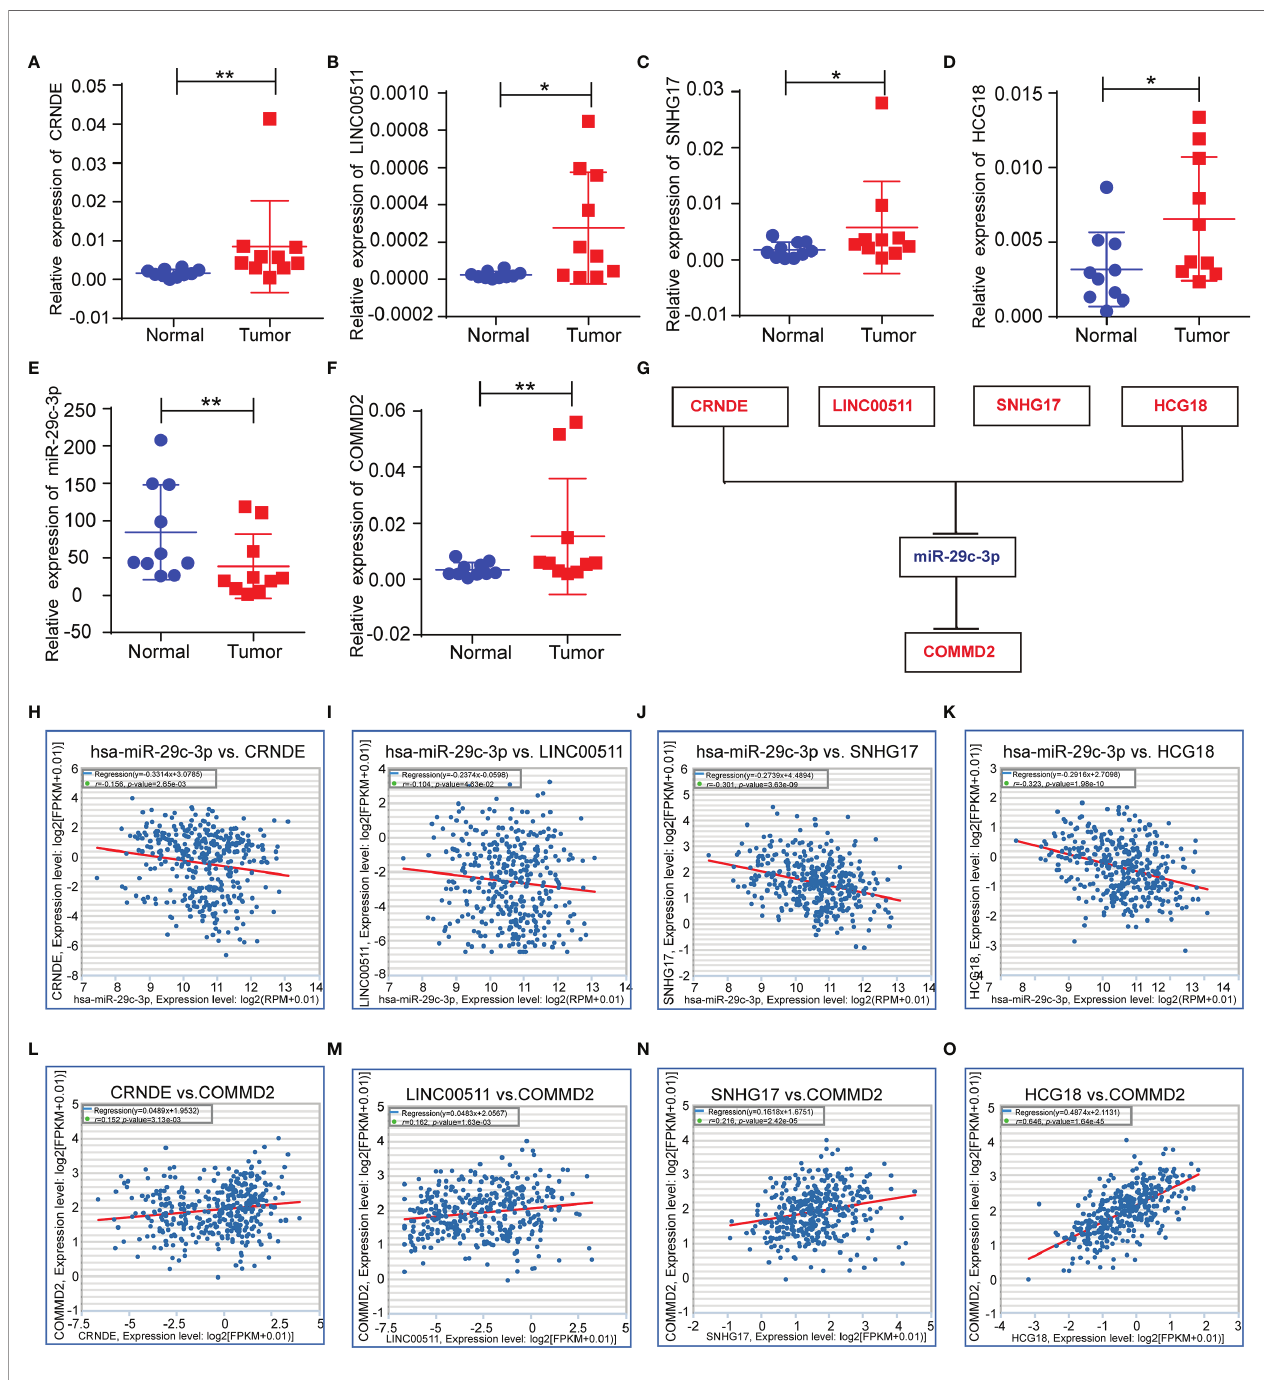
FIGURE 6 | Correlations of lncRNAs with miR-29c-3p and COMMD2 in LIHC. (A – F) Expression of crucial ncRNAs and COMMD2 in fresh LIHC specimens and adjacent normal tissue as determined by RT-qPCR. (G) Schematic model of the ceRNA network. Red indicates upregulation and blue indicates downregulation. (H – K) Correlations of CRNDE (H) , LINC00511 (I) , SNHG17 (J) and HCG18 (K) with miR-29c-3p in LIHC. (L – O) Correlations of CRNDE (L) , LINC00511 (M) , SNHG17 (N) and HCG18 (O) with COMMD2 in LIHC. *p < 0.05; **p <